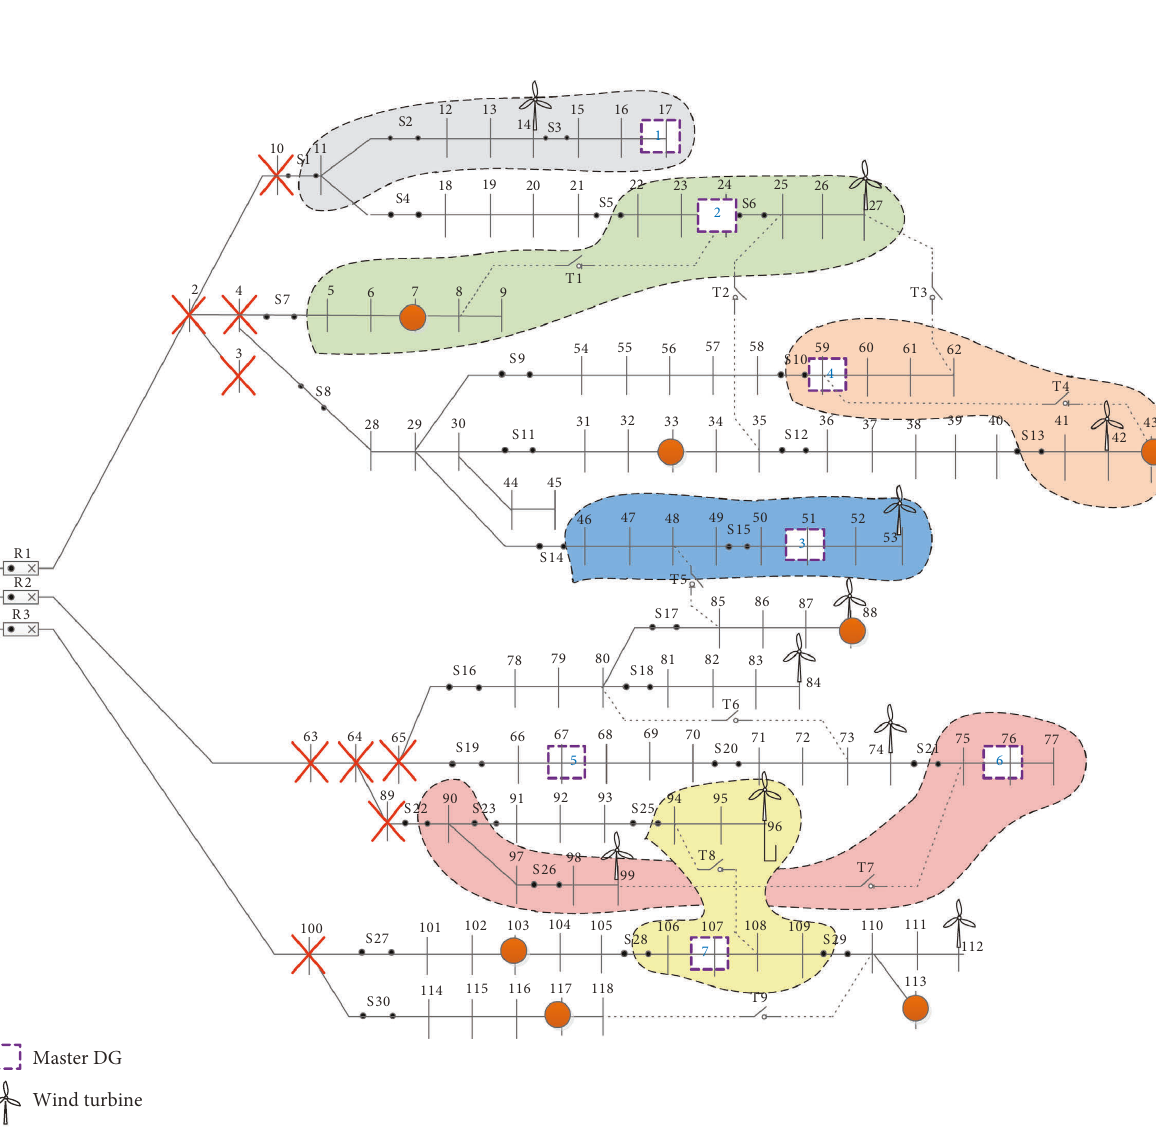
Figure 10: Optimal islanding plan in case